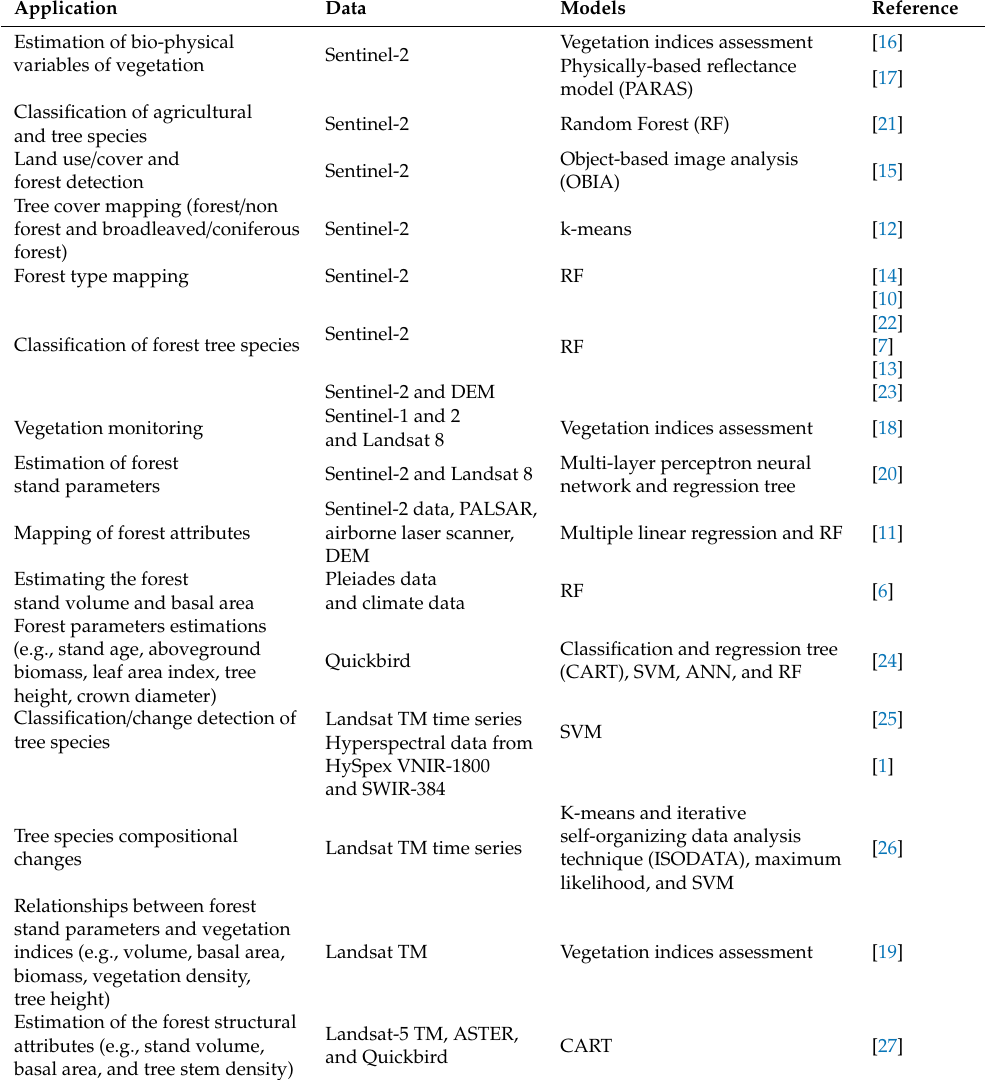
Table 1. Brief review on details and applications of RS data in forestry and